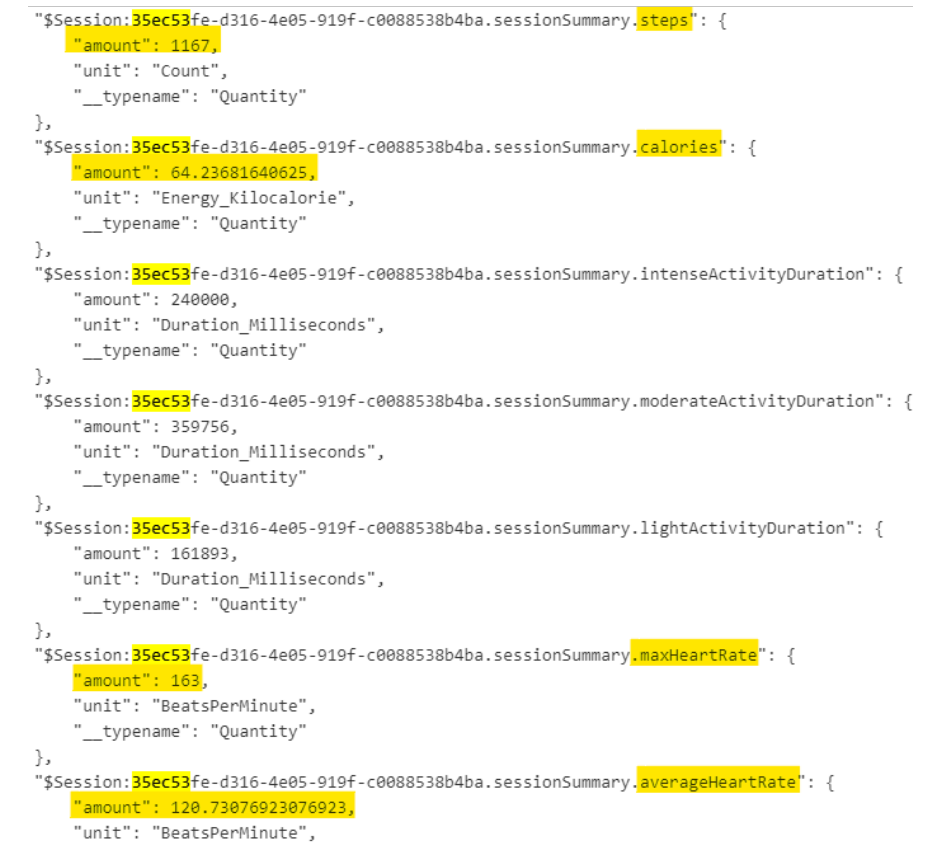
Figure 7. Session summary from the workout the Amazon Halo user did during session 35ec53fe- d316-4e05-919f-c0088538b4ba